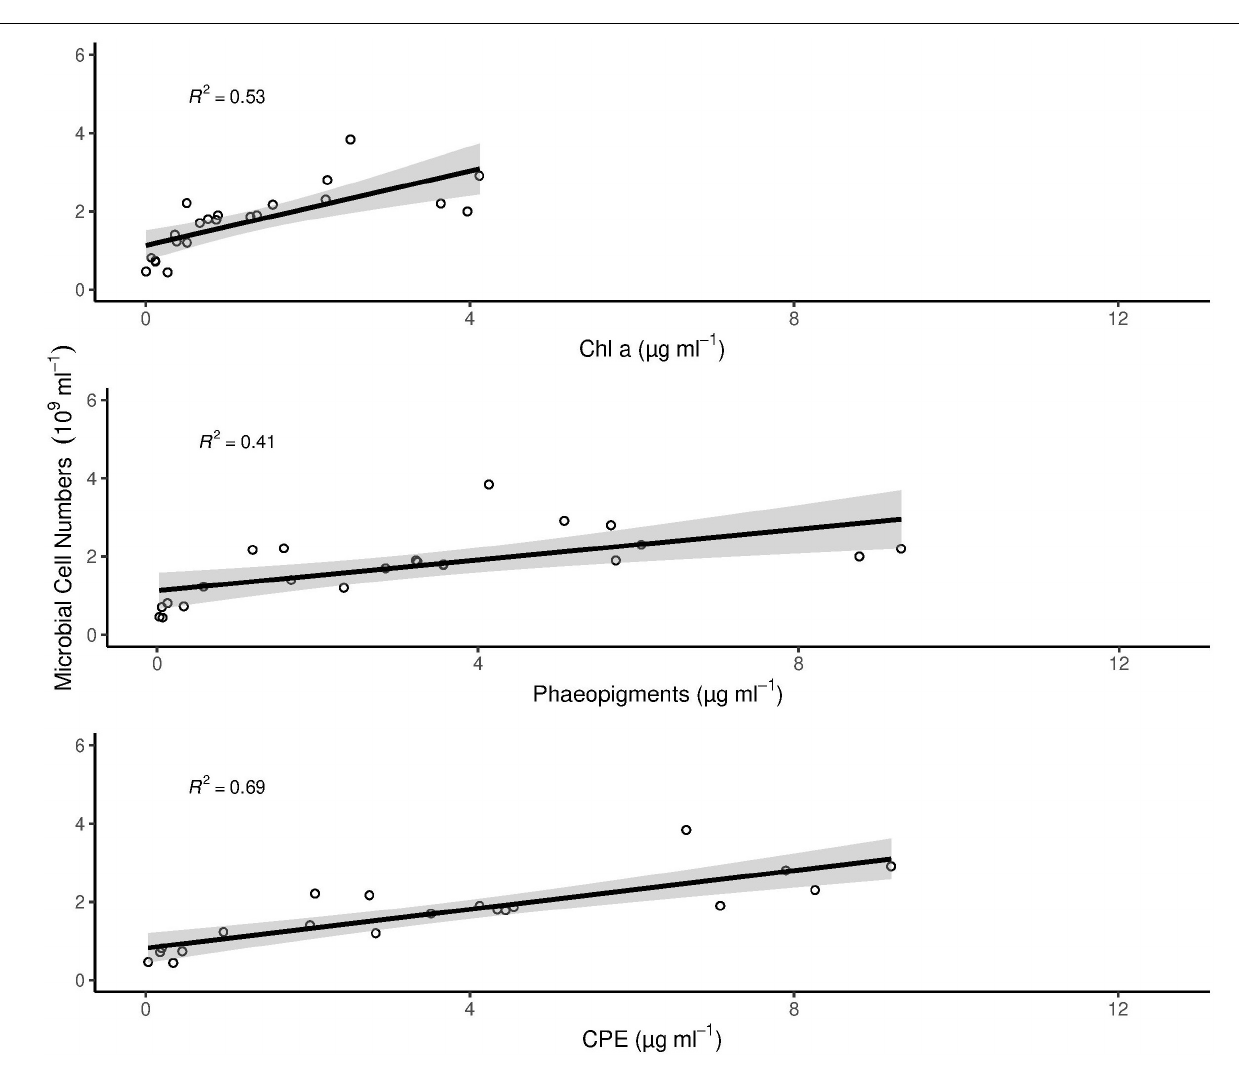
FIGURE 3 | Correlation of chlorophyll pigments with microbial cell numbers. The gray area around the linear model in each panel plot represents the 95% confidence interval. All correlations are statistically significant ( p < 0.005). In the figure, multiple R 2 is shown. Adjusted R 2 for Chl a = 0.5; Phaeopigments = 0.38 and CPE =